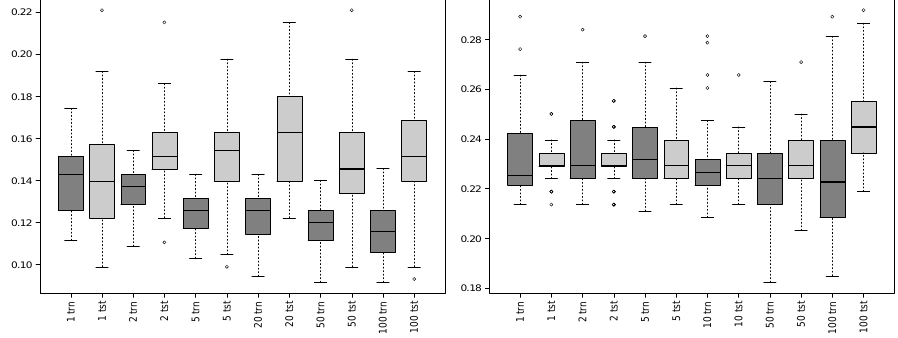
Fig. 9. Distribution of training MR (dark gray) and test MR (light gray) for at least 30 runs. (Left) Results of LGP on the credit card data set varying over n prog . (Right) Results of neural networks on the corrected diabetes data set varying over the number of hidden